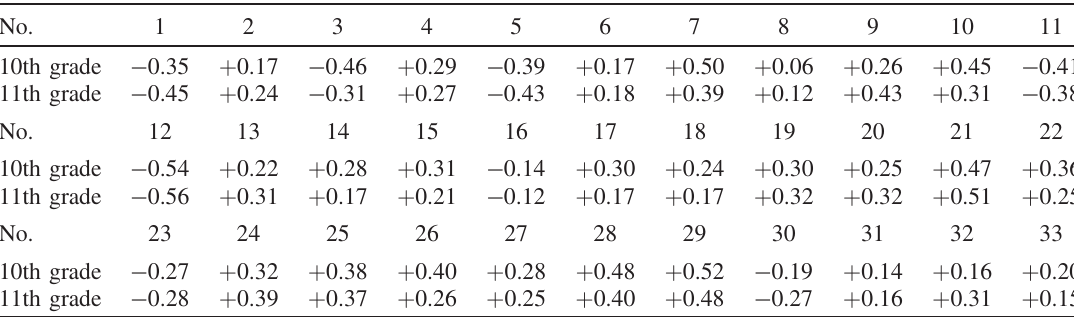
TABLE IX. Normalized scores on each item for different grade levels.